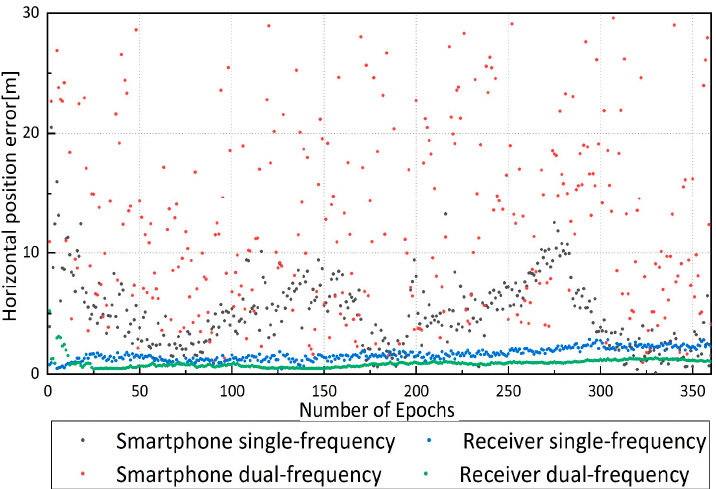
Figure 8. Horizontal position errors of four data sets in kinematic mode.